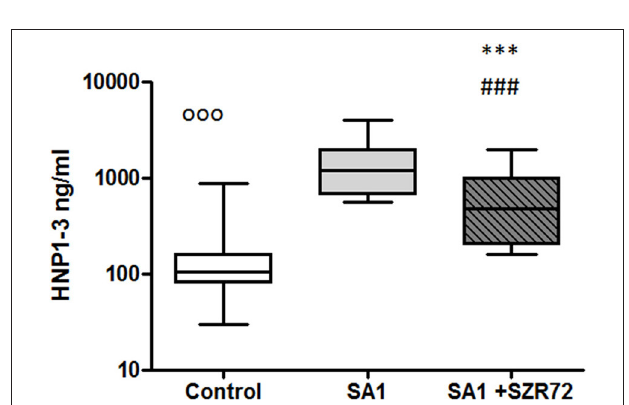
FIGURE 10 | The effect of KYNA analog, SZR72 on HNP1–3 production in human whole blood cells of normal blood donors stimulated by heat-inactivated Staphylococcus aureus. Ethylenediaminetetraacetic acid (EDTA)-anticoagulated blood samples 1–1ml from each of 50 healthy donors were incubated with SZR72 at a concentration of 500 µ m for 30min prior to the addition of heat-inactivated Staphylococcus aureus (10 7 /ml). The concentrations of HNP-1 in the plasma were determined after an 18 h-incubation period. The data are depicted as box and whiskers plots, where the lines inside the boxes denote medians, and the boxes mark the interval between 25 and 75 percentiles, and the whiskers, the maximum and minimum. Significance was determined by the Friedman’s test. The values, ooo p < 0.001 in control vs. SA1, ### p < 0.001 in control vs. SA1 + SZR72, *** p < 0.001 in SA1 + SZR72 vs.